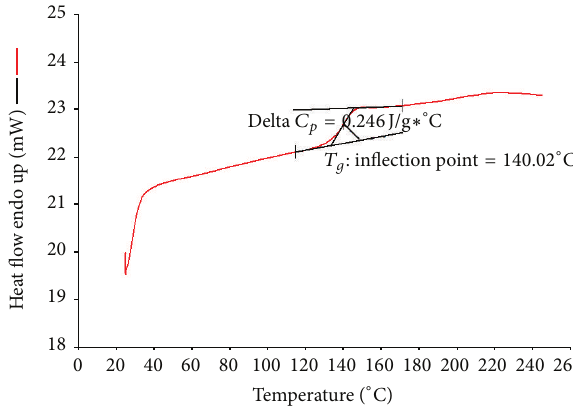
Figure 10: DSC scan of FBE coating system after immersion in distilled water for 30 days at 93 ∘ C/200 ∘ F.